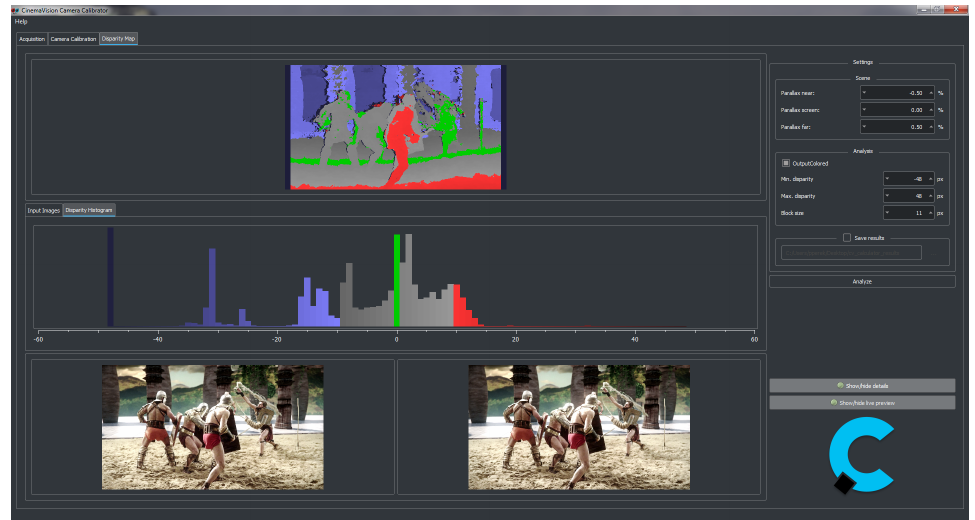
Figure 7. Graphical user interface for the disparity map calculation